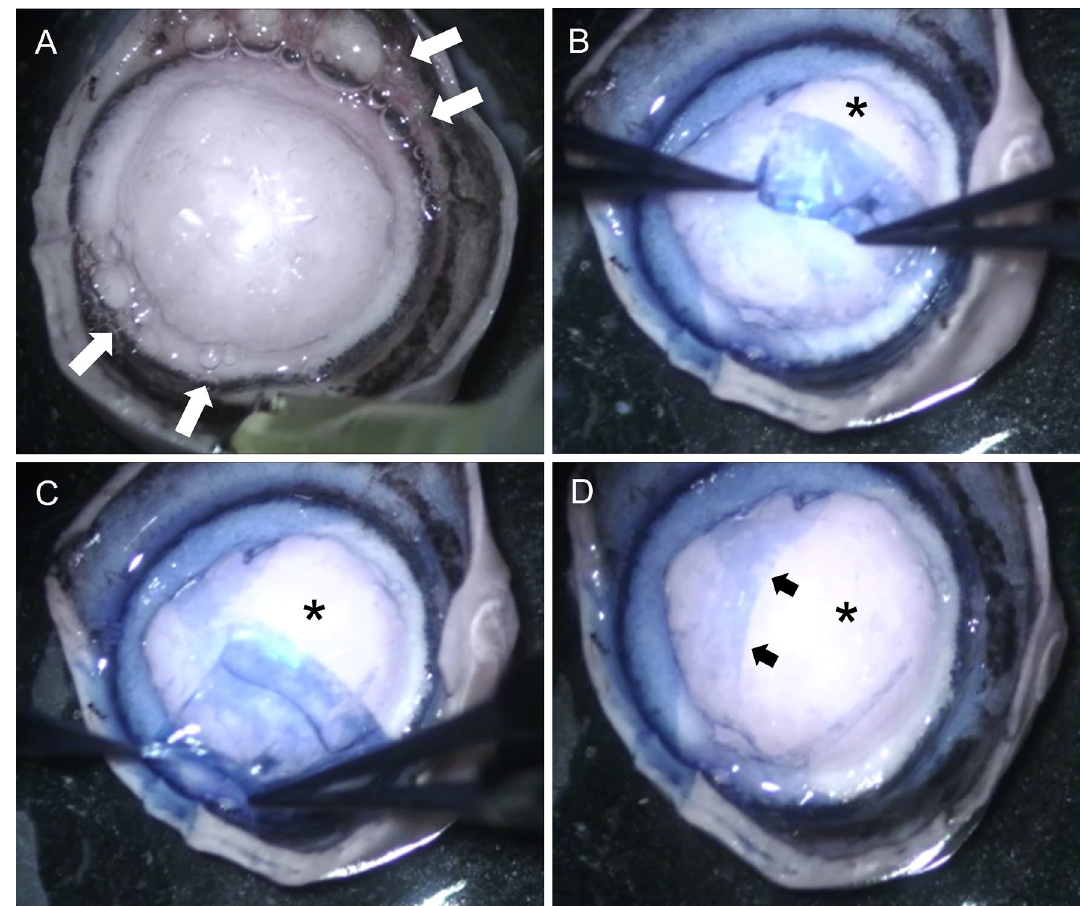
Figure 1. Macroscopic photographs of a type 1 big bubble (BB) in canine cornea after pneumodissection (corneal endothelium facing up). ( A ) A large central type 1 BB is present. White arrows point to the bubbles of air escaping from the periphery along the pigmented tissue. These bubbles are likely to enter the anterior chamber during big bubble deep anterior lamellar keratoplasty. ( B ) The Descemet’s membrane (DM) is being peeled off the BB revealing the posterior surface of the canine pre-Descemet’s layer (cPDL) (star). ( C ) On further peeling the DM tears as a broad strip, revealing more of the cPDL (star). ( D ) A broad central strip of the DM is peeled off. The edge of the remaining DM is clearly seen (black arrows). The DM was stained with vision blue dye ( B – D